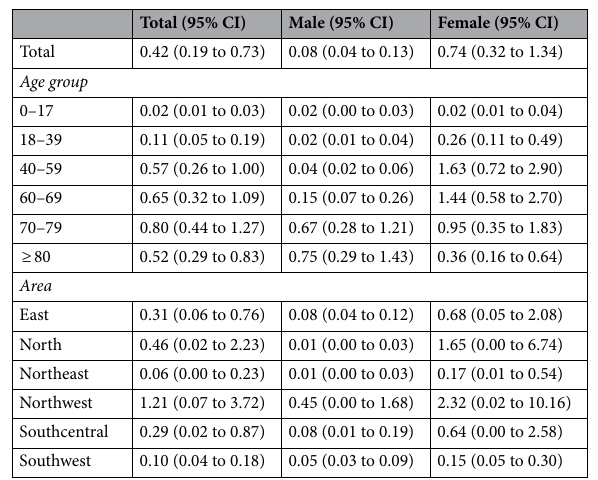
Table 3. Unadjusted prevalence of mammary Paget’s disease in urban population from 23 provinces in China in 2016 (unit: /100,000